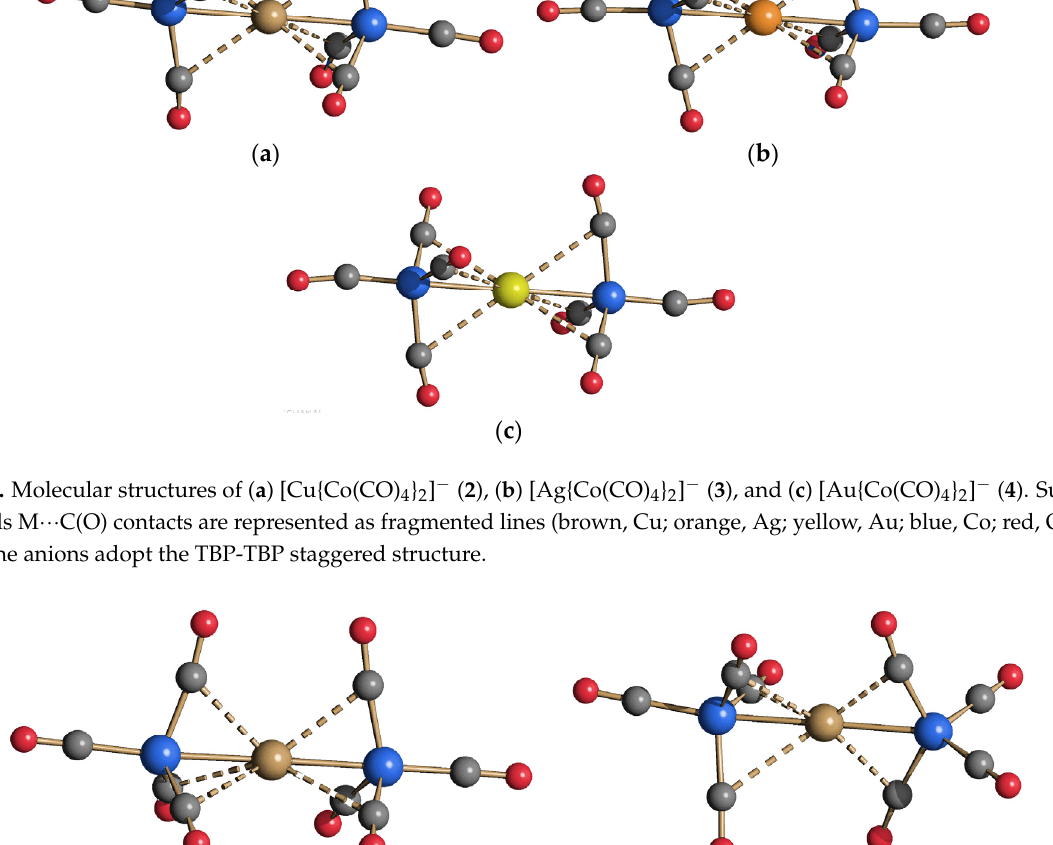
( c ) Figure 5. The three isomers of 2 : ( a ) TBP-TBP staggered; ( b ) TBP-TBP eclipsed; ( c ) TBP-Td. Sub Van der Waals M ··· C(O) contacts are represented as fragmented lines (brown, Cu; blue, Co; red, O; grey, C) [39–41]. The reactions of [PPN]( 1 ) with M(I) salts resulted in species showing ν CO bands in the IR spectra similar to 2 – 4 . Indeed, crystals of [PPN]( 2 ) and [PPN]( 4 ) suitable for